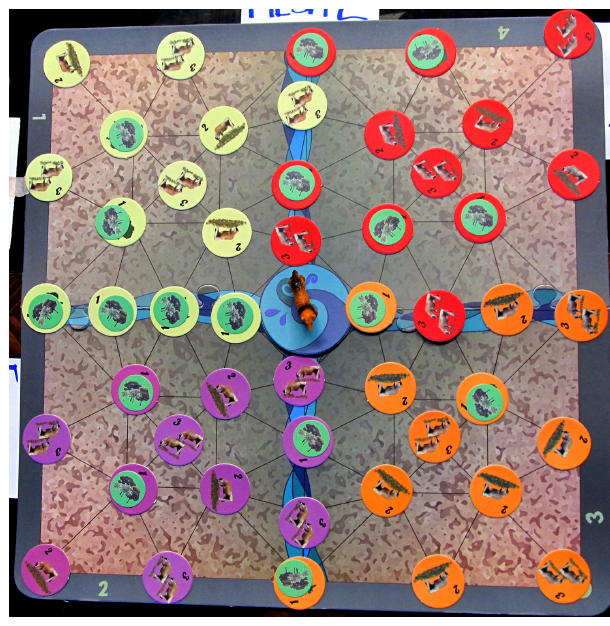
Fig. 1 . The Sierra Spring table board and token display near the end of a session 1 game. Each player has a quadrant and distinct token color. Sites on creeks bordering quadrants are owned based on a first come first served rule. Land-use values are: F (managed forest) = 1; M (moderate grazing) = 2; I (intensive grazing) = 3. Token deployment is reversible at any time. The fixed rules allow all players to survive by making at least 24 points each without breaching the 4 environmental limits and land-use restrictions. There are thousands of solutions, but finding one is nontrivial for most people. In this image, 31 sites have been deforested out of the maximum allowable 32. Players 1, 2, and 3 have achieved 24 points but player 4 is still lacking a point and the quadrant 3/quadrant 4 border is breaching the rule: no more than 2 deforestations on a creek. If player 3 fixes the creek by changing his M token to an F token, he too will be lacking a point; if player 4 does, he will be in an even worse situation. Who will yield? What needs to be rearranged among all or some players so they can all